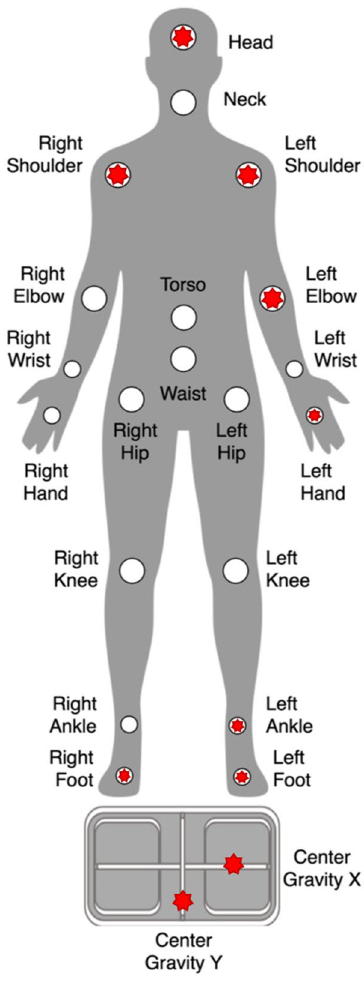
Figure 3. Top-ranked body features used by RF classifiers, marked as red